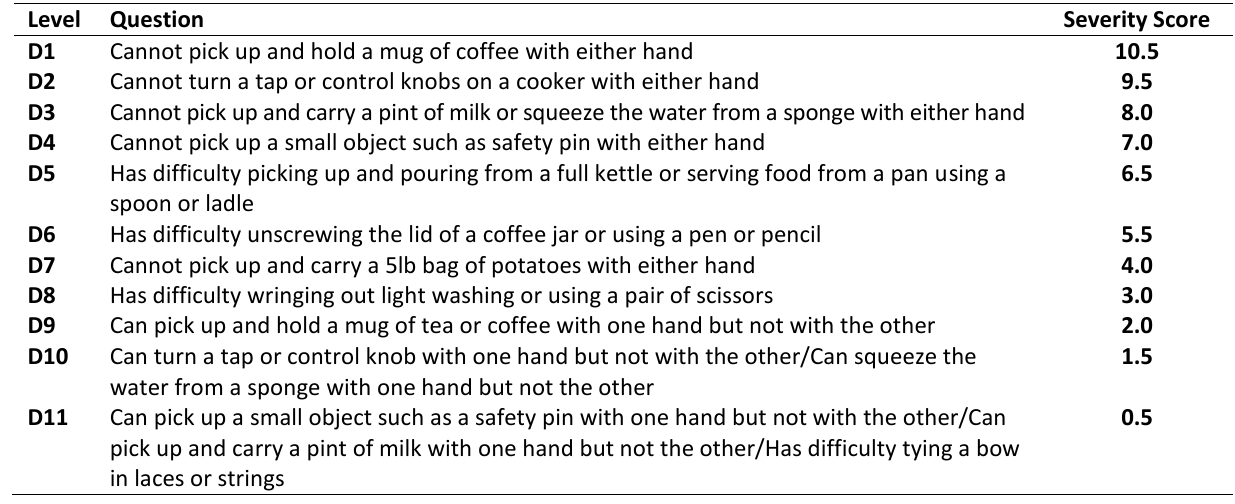
Table 4. Different levels of dexterity and respective severity scores. Sources: Grundy et al. (1999) and Martin et al. (1988).